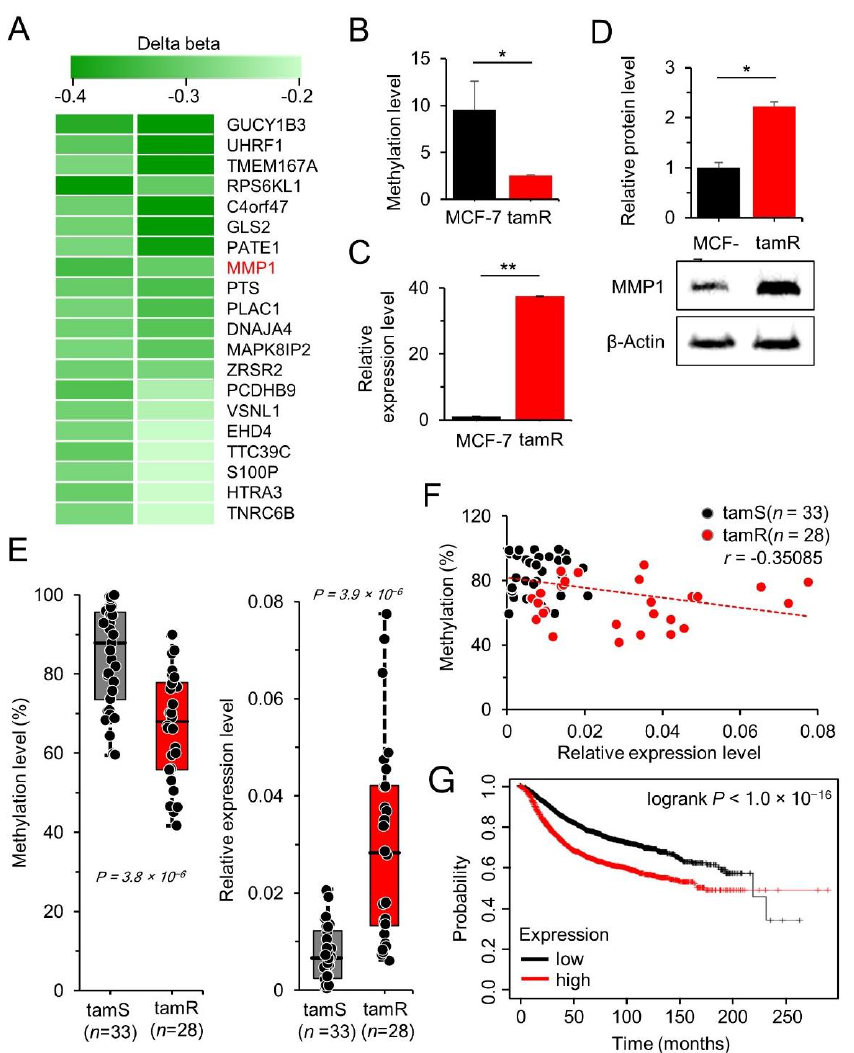
Figure 1. MMP1 is hypomethylated and upregulated in tamR breast cancer compared to that in tamS breast cancer. ( A ) Heatmap of the 20 most hypomethylated genes in MCF-7/tamR cells compared to those in parental MCF-7 cells. Data of two arrays are presented. Methylation level of the CpG site at the MMP1 promoter ( B ) and mRNA level ( C ) were analyzed by MSP and qRT-PCR in breast cancer cells. The data are presented as mean ± SE of three independent experiments. ( D ) Western blot analysis was performed to detect MMP1 protein level in cultured cells. ( E ) Hypomethylation and upregulation of MMP1 were identified by MSP and qPCR in breast cancer tissue of patients. n: number of samples. ( F ) The association between the CpG methylation and mRNA expression of MMP1. ( G ) Kaplan – Meier survival curve of MMP1 level in breast cancer patients. Samples ( n = 1379) were categorized into tertiles based on MMP1 expression. Distant metastasis-free survival (DMFS) was compared for all tumor samples using the log-rank test ( p < 0.001). * p < 0.05, ** p < 0.01, *** p < 0.001. Table 1. Top twenty hypomethylated genes in the MCF-7/tamR cells. Gene Symbol Accession No. Description GUCY1B3 NM_000857 guanylate cyclase 1 soluble subunit beta 1 − 0.47 − 2.24